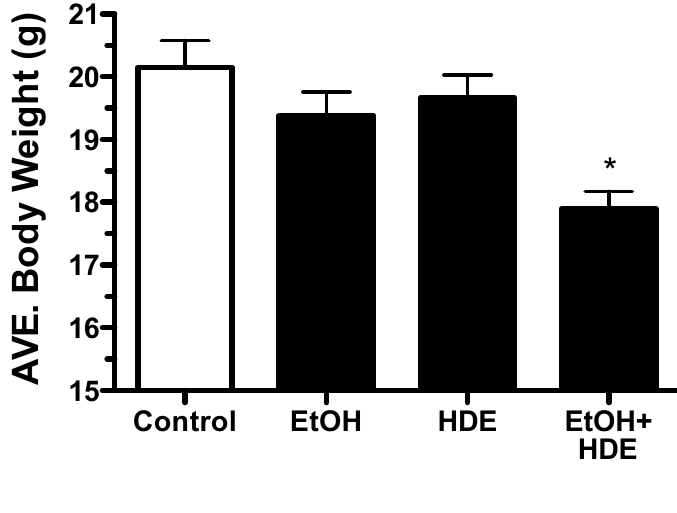
12.5% hog barn dust extract (HDE) intranasally for 3 weeks ( n = 5). Body weights of the alcohol + HDE group were statistically lower as compared to control group